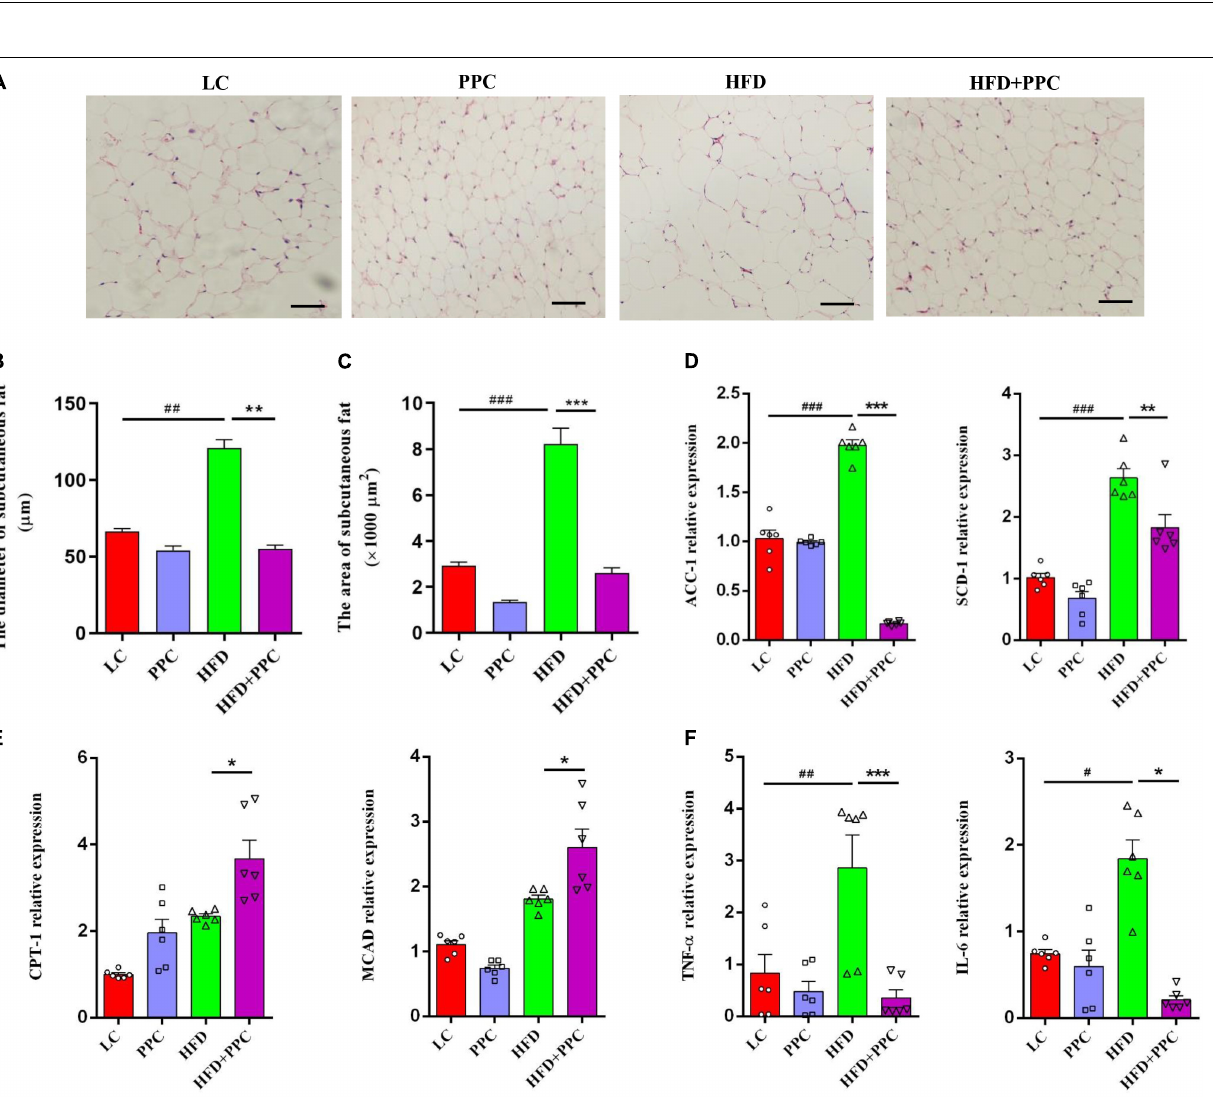
FIGURE 8 | PPC supplementation enhances lipolysis and alleviates inflammation in the subcutaneous adipose tissues of mice fed by HFD. (A) Representative adipose tissue images of H&E staining. (B) The statistical results of subcutaneous adipocyte diameter. (C) The statistical results of subcutaneous adipocyte superficial area. (D) The expression of key enzymes in synthesis of fatty acids. (E) The expression of key enzymes related to fatty acid oxidation. (F) The expression of genes related to inflammation. The scaleplate of the representative images is 50 µ m. n = 6 for each group. The differences were analyzed using ANOVA. Data represent means with SEM. The pound signs indicate statistically significant differences compared to the LC group. # P < 0.05, ## P < 0.01, ### P < 0.001. Asterisks indicate statistically significant differences compared to the HFD group. * P < 0.05, ** P < 0.01, *** P < 0.001.